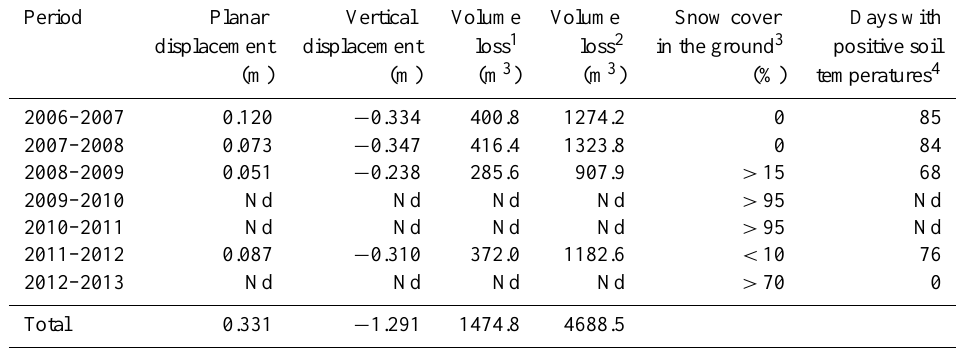
Table 3. Synthesis of values for movement (middle stretch of the rock glacier), loss of volume, snow cover and days with positive temperature. Period Planar Vertical Volume Volume Snow cover Days with displacement displacement loss 1 loss 2 in the ground 3 positive soil (m) (m) (m 3 ) (m 3 ) (%) temperatures 4